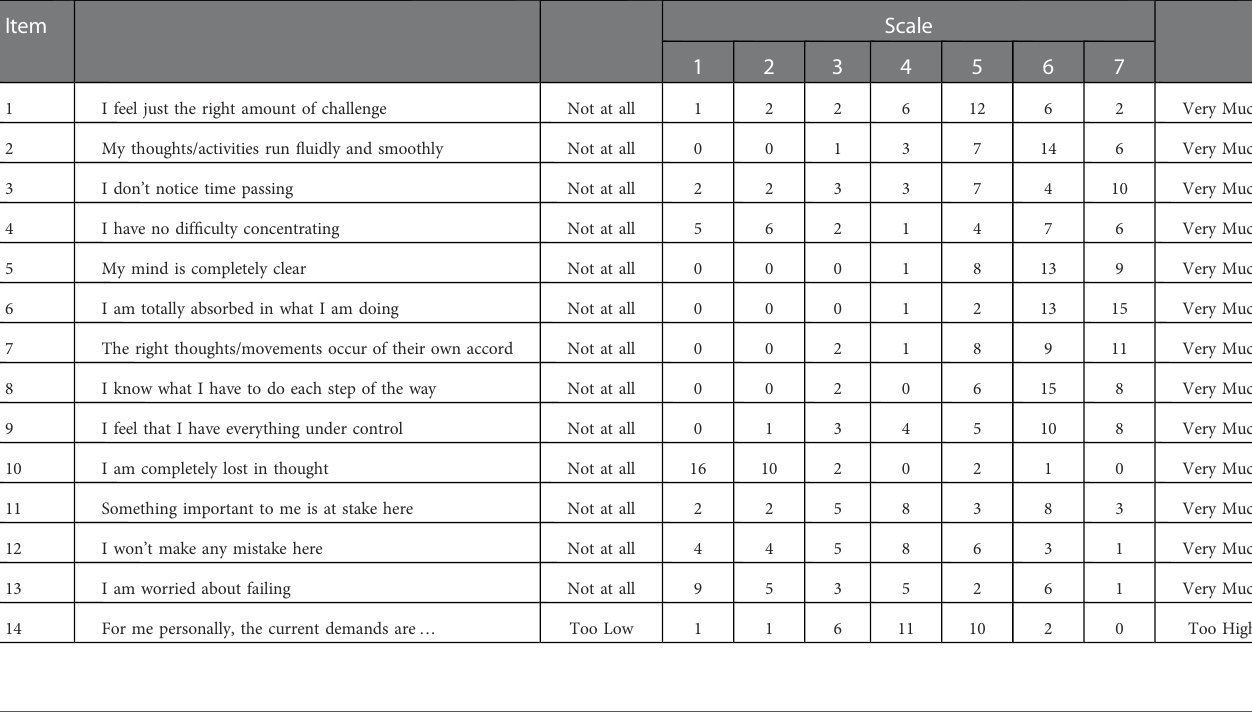
TABLE 4 Summary of fl ow short scale results.